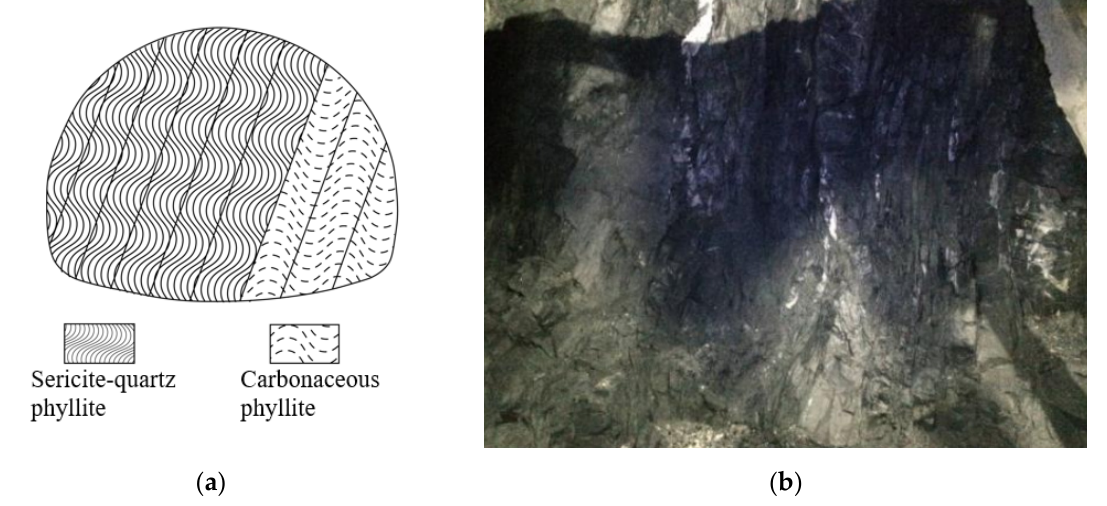
Figure 13. Tunnel face (unexcavated) at K143 + 630. ( a ) Geological sketch picture. ( b ) Photo of the tunnel face. The pre-excavation boreholes are arranged on the tunnel face (Figure 14), the rock cores are collected via pre-excavation boreholes for investigation, and the RBI value of rock mass (Table 5) for each borehole is calculated using Equation (9) and the core length measured on site. For the monitoring of surrounding rock mass deformation after excavation, the on-site monitoring point placement is illustrated in Figure 14.